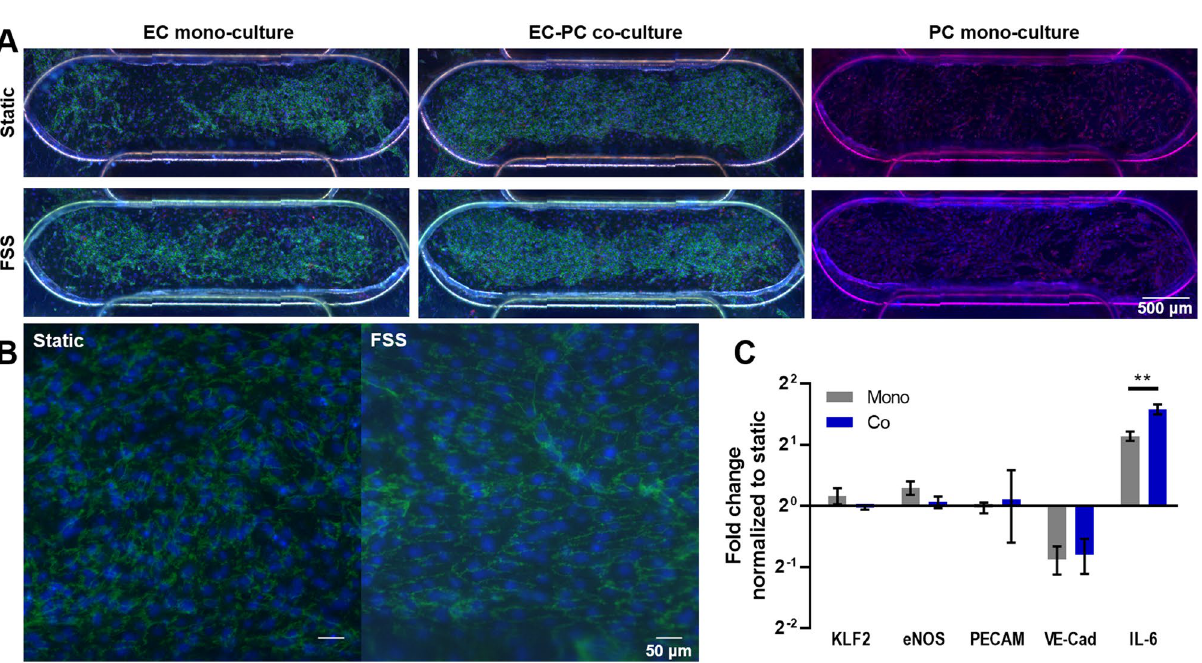
Figure 7. Vascular model response to low fluid shear stress (FSS). ( A ) Representative images of devices 24 h after exposure to low FSS. ( B ) Higher magnification shows some alignment of EC in response to fluid flow. ( C ) Gene expression of ECs from mono- and co-cultures showed that IL-6 was significantly increased in flow, while VE-CAD expression was significantly decreased. IL-6 was also significantly increased in co-culture compared to mono-culture under